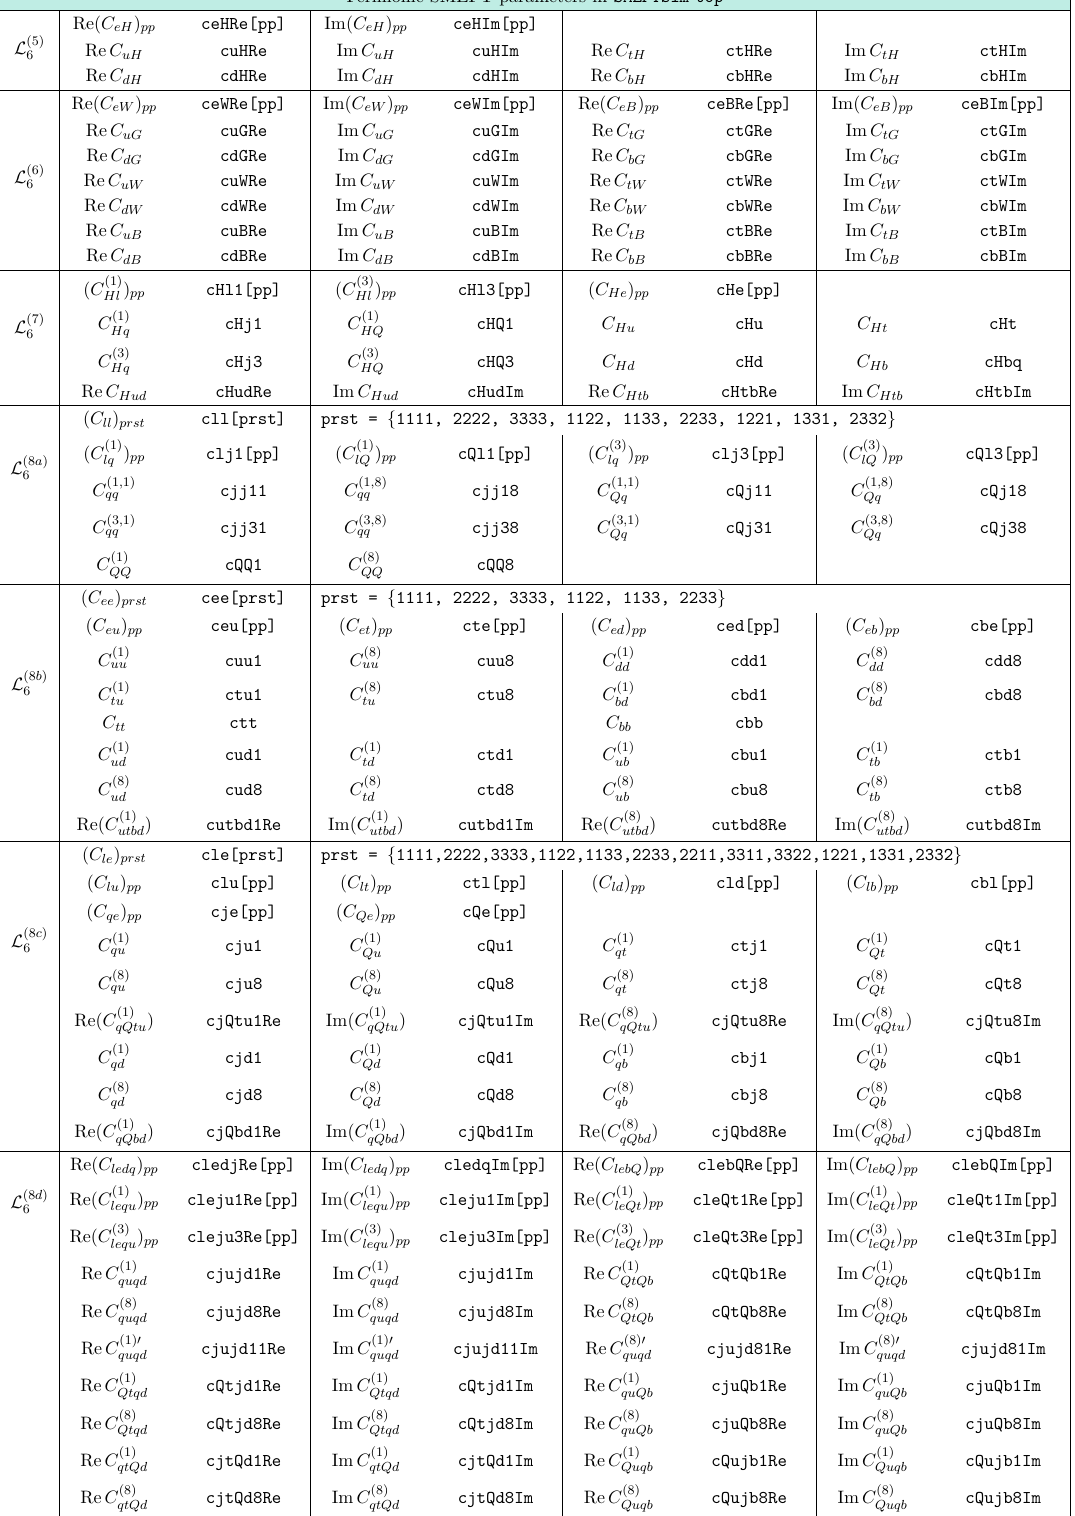
defined in the top model, see section 3.4. 6